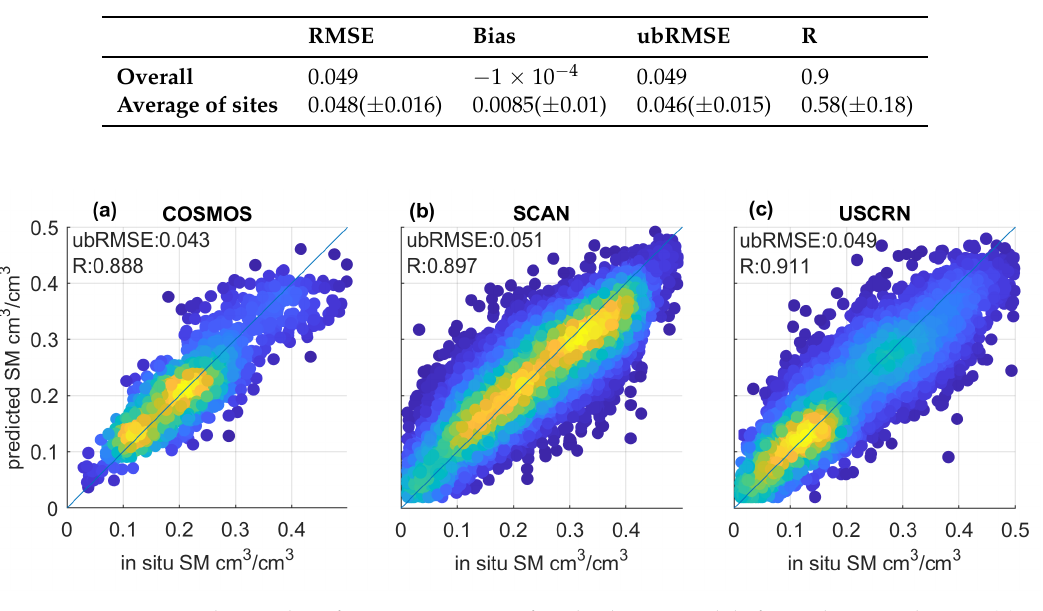
Figure 11. Scatter plots and performance metrics of multiple ML models for each network type: ( a ) the COsmic-ray Soil Moisture Observing System (COSMOS), ( b ) the Soil Climate Analysis Network (SCAN), and ( c ) U.S. Climate Reference Network